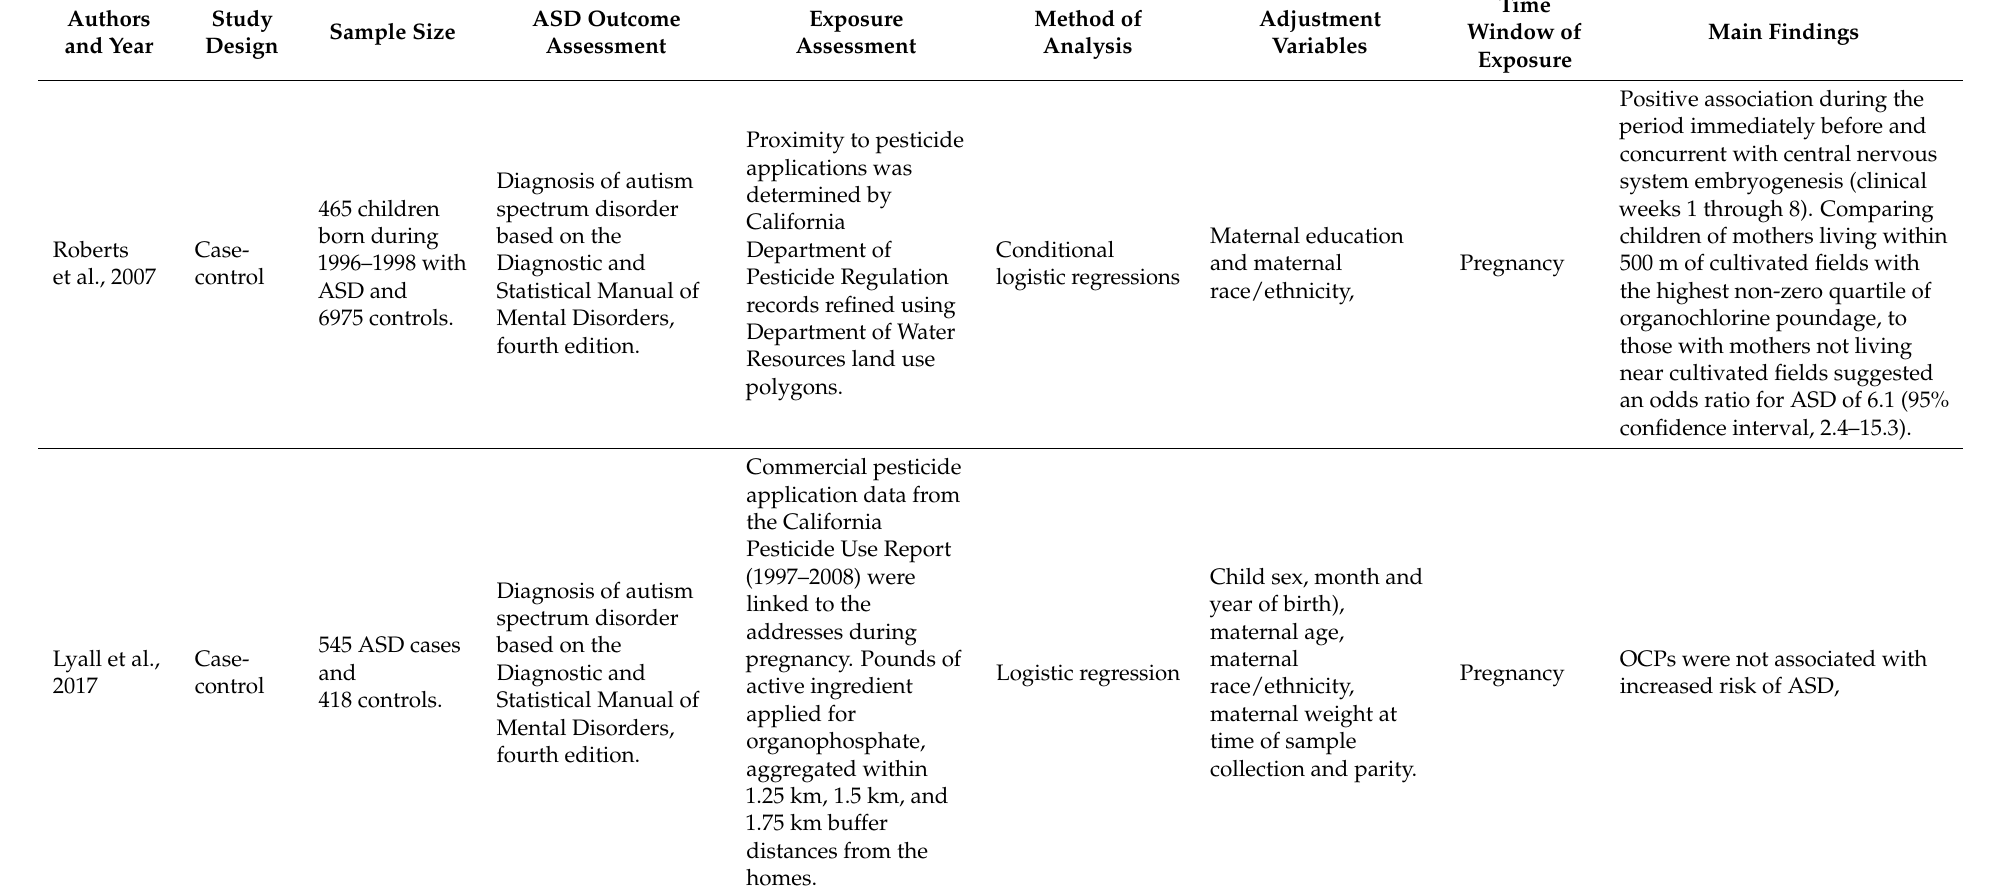
Table 2. Associations between organochlorine pesticides (OCPs) and